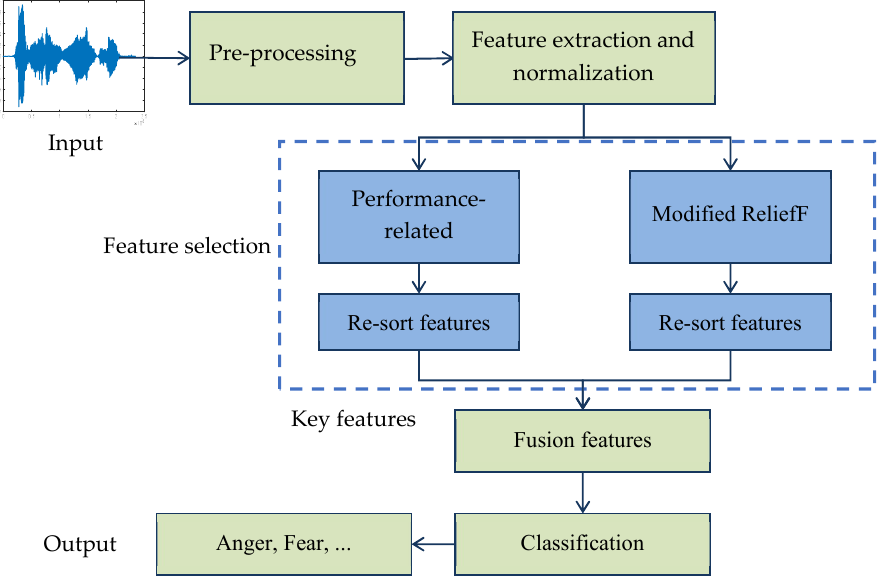
Figure 1. Block diagram of the speech emotion recognition.